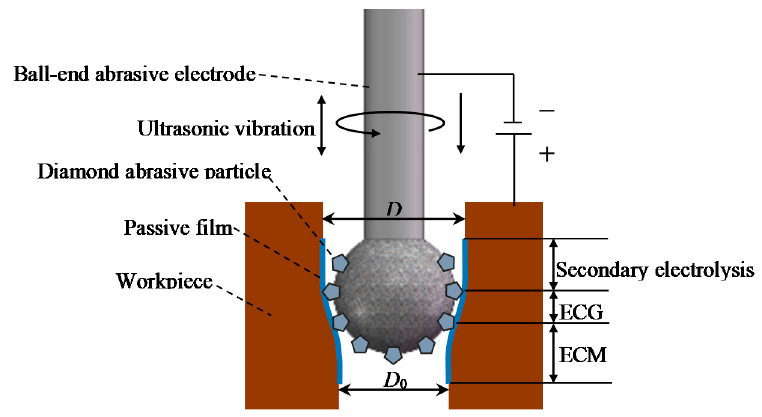
Figure 7. Schematic diagram of UAECDG.